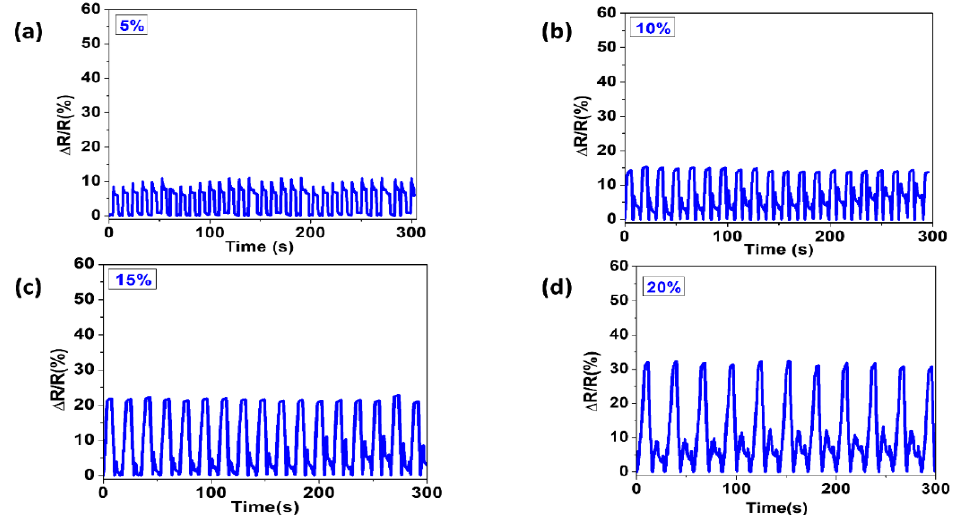
Figure 4. Change in resistance of purl structure under different strain percentage. ( a ) 5%, ( b ) 10%, ( c ) 15%, and ( d ) 20%.